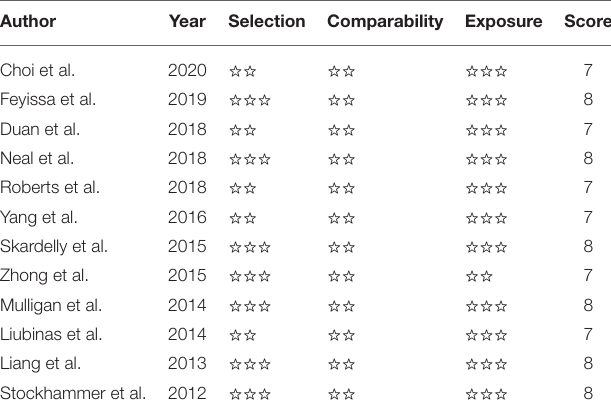
TABLE 3 | Evaluation of the study